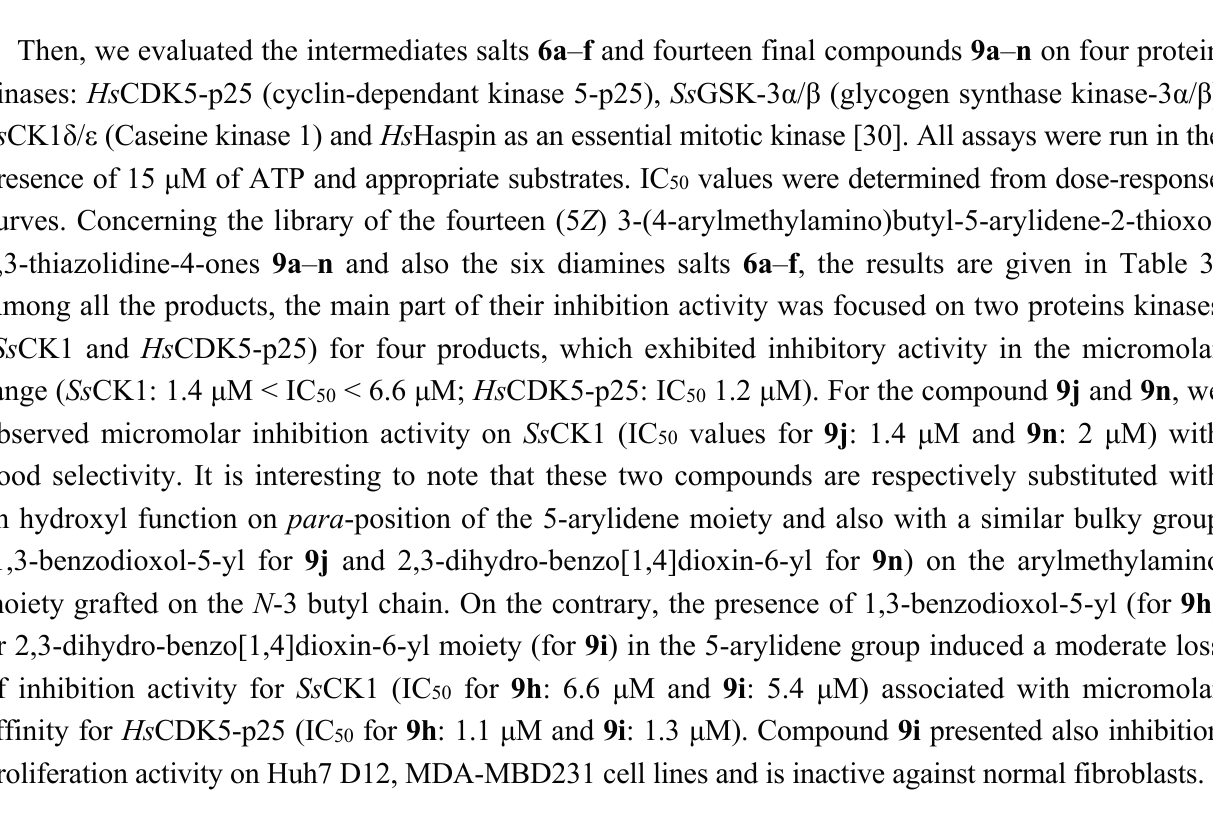
Table 3. Effects of the compounds 6a – f and 9a – n on the catalytic activity of four purified protein kinases a